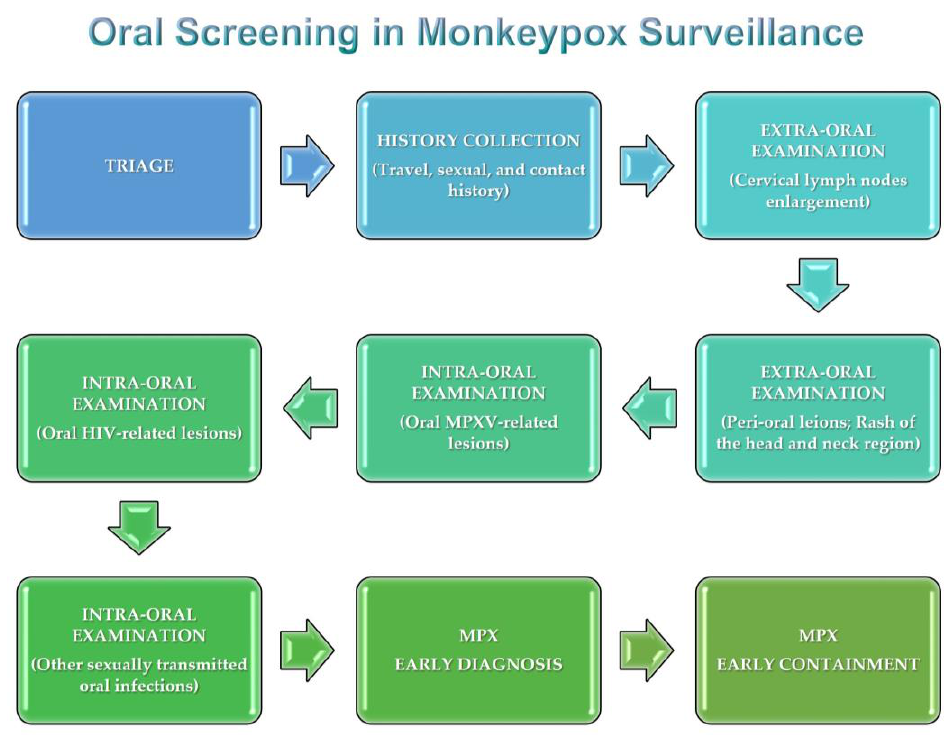
Figure 4. Oral screening in MPX surveillance.